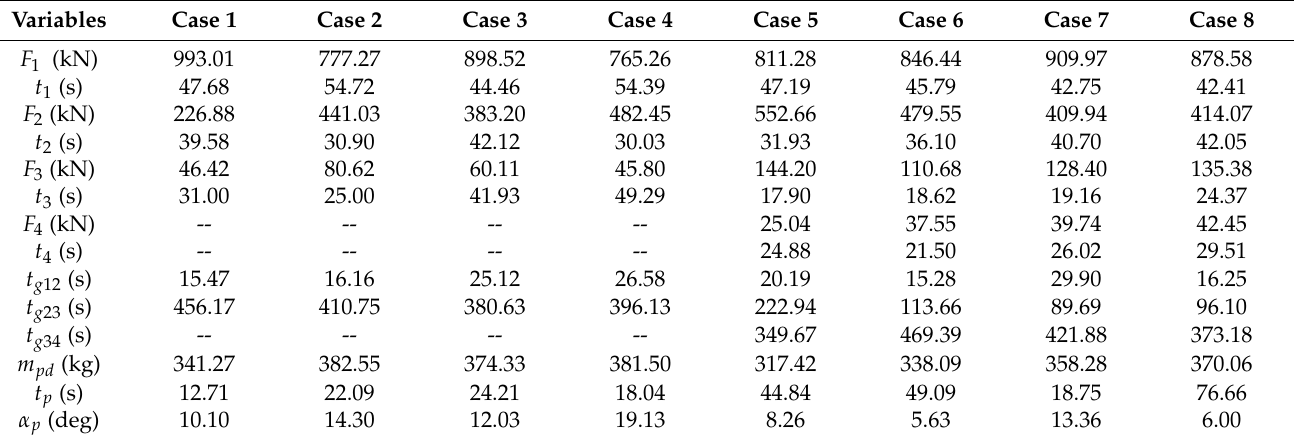
Table 6. Optimal results of the eight design cases.